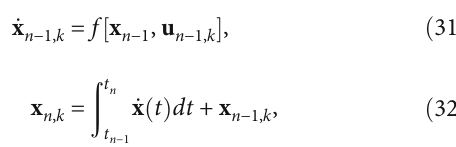
Table 4: Performance for di ff erent